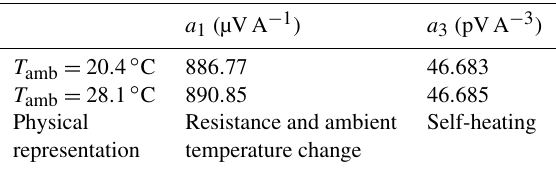
Table 3. Extracted parameters a 1 and a 3 using polynomial curve fitting for different ambient temperatures.